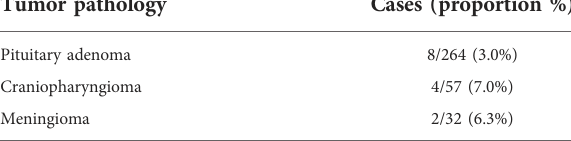
TABLE 5 Frequency of postoperative CSF leakage among tumor